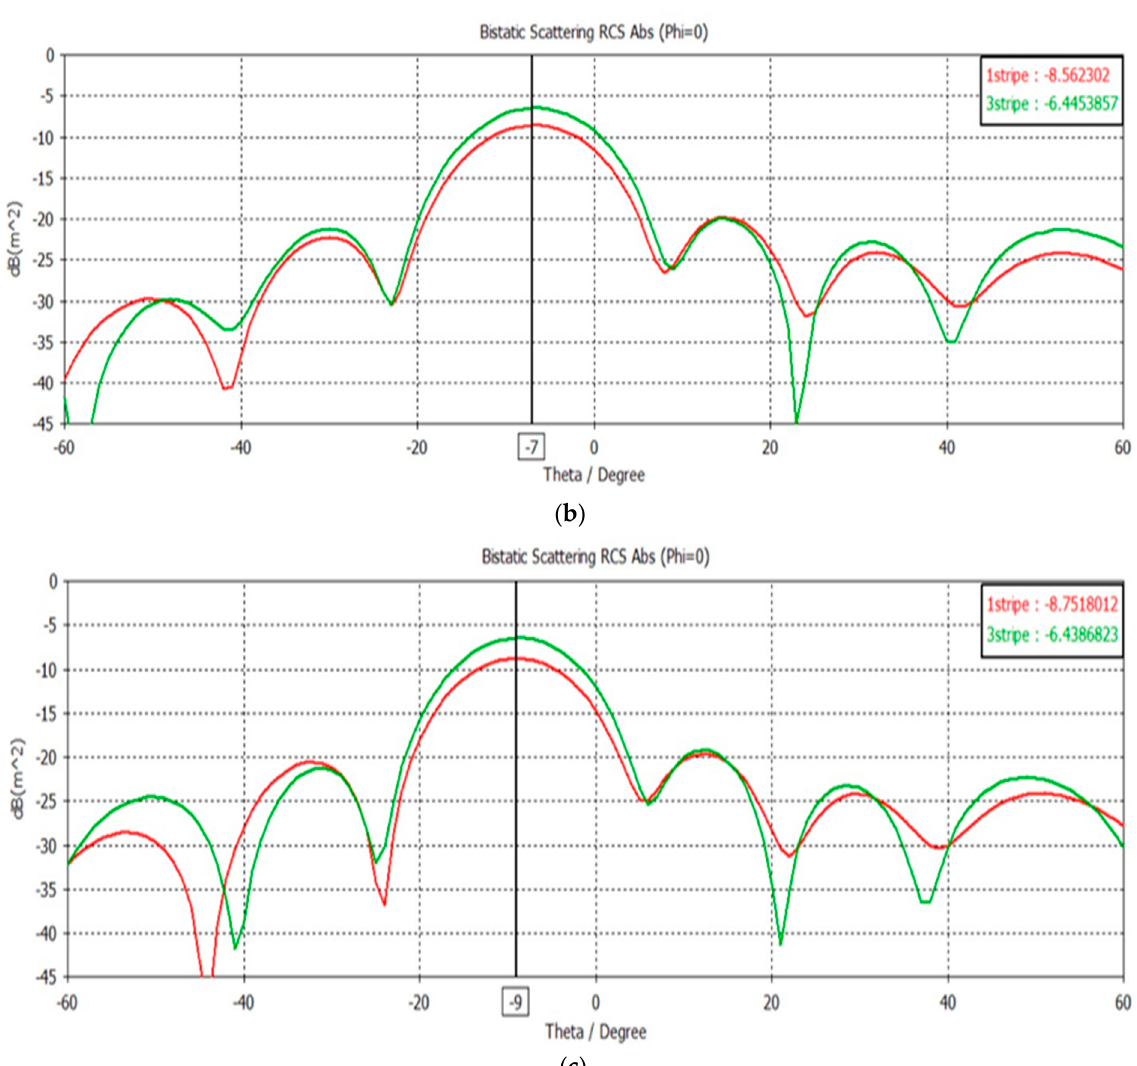
Figure 7. Beam steering far-field radar cross section (RCS) results at 28 GHz in the three-stripe configuration (green) vs. the one-stripe configuration (red). ( a ) Steering angle simulation results of 5°. ( b ) Steering angle simulation results of 7°. ( c ) Steering angle simulation results of 9°.